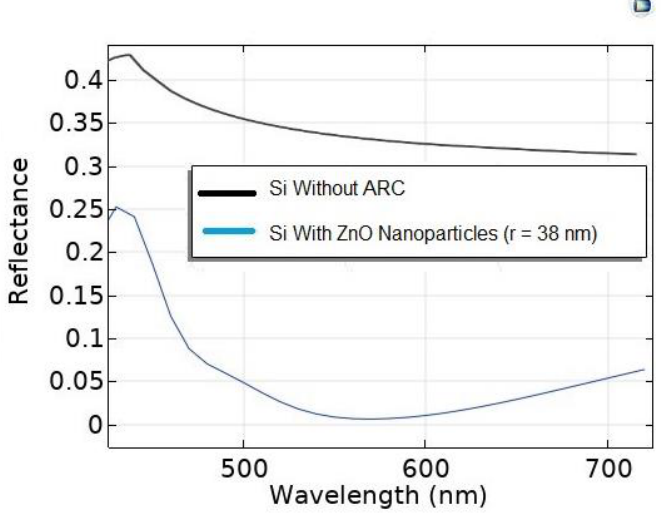
Figure 8. Reflectance spectra of ZnO nanoparticles with radius 38 nm for Si cell obtained by COMSOL Multiphysics model.